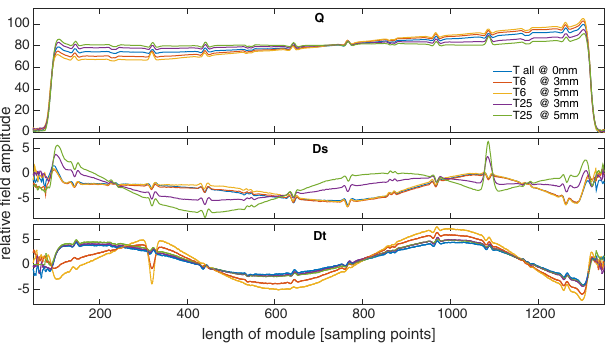
FIG. 9. The plot shows the development of the measured relative longitudinal field distribution by moving the tuners T6 and T25 inside by 3 mm and 5 mm respectively. The maximal initial field of Q is normalised to